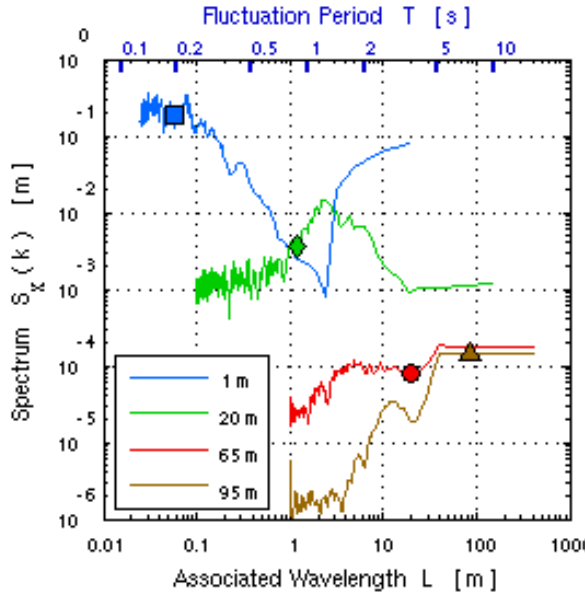
Fig. 7. Power spectral density of the four normalized irradiance pro- Figure 7. Power spectral density of the four normalized irradiance profiles from Fig. 6; 3 files from Fig. 6; the mean fluctuation lengths L m are additionally marked (30 October the mean fluctuation lengths L